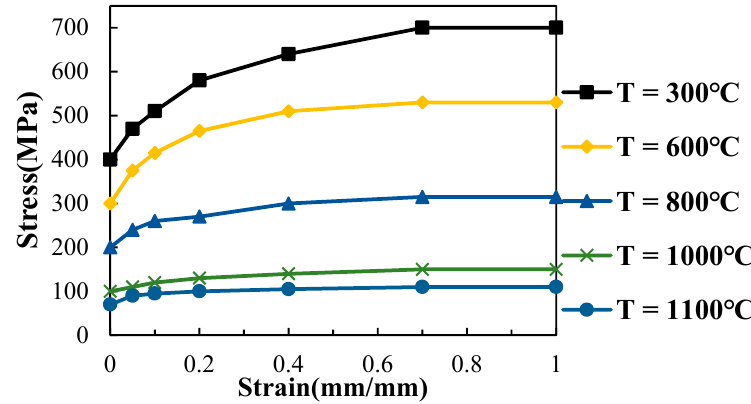
. ε = 0.25. Figure 9. Flow stress curves of SUS304 at 𝜀(cid:4662) = 0.25.